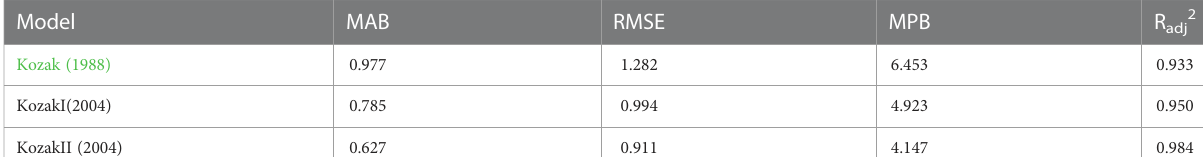
TABLE 3 Goodness-of- fi t statistics of variable exponential taper equations using the cross-validation phase.